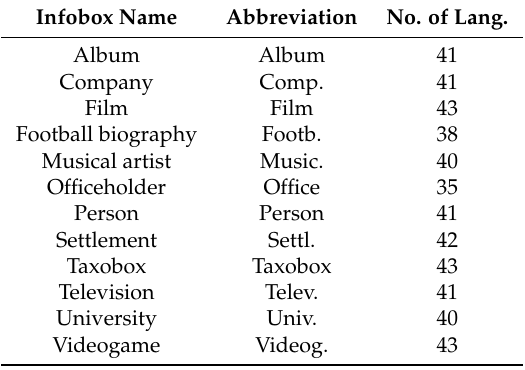
Table 4. Number of considered language versions of Wikipedia with particular infobox. Source: own calculation.